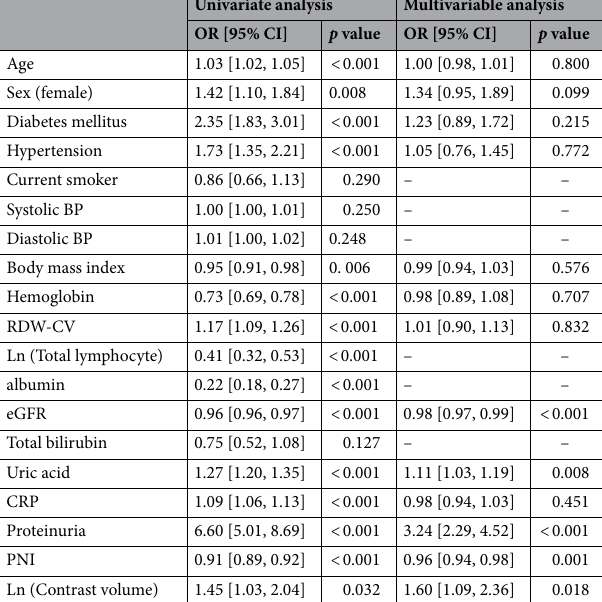
Table 2. Further analysis for the cause of death, such as cardiac death or non-cardiac death, is shown in Supple- mentary Table 3. Low PNI was still a significant risk factor for cardiac death [HR 0.96, CI 0.93–0.98, P = 0.003],